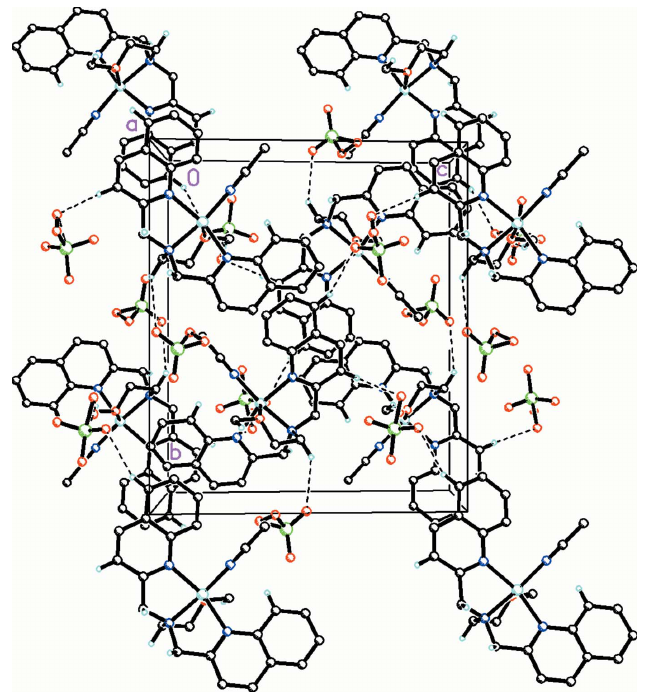
Figure 2 Crystal packing of the title compound viewed along the a axis. The intermolecular C—H (cid:2)(cid:2)(cid:2) O hydrogen bonds (Table 2) are shown as dashed lines. (cid:2) – (cid:2) stacking of the quinoline rings along the a axis can be seen in the center of the